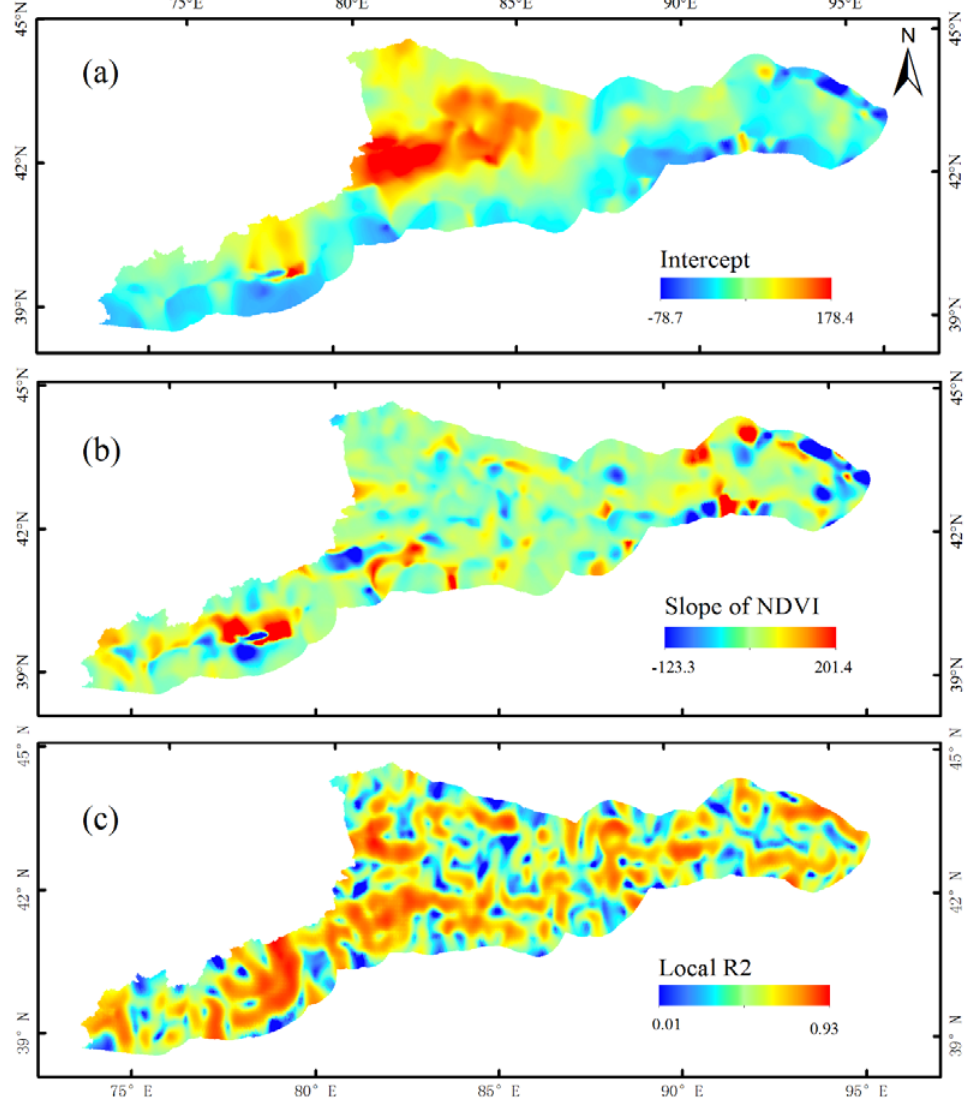
Figure 3. The spatial distributions of the ( a ) intercept, ( b ) slope of the NDVI and, ( c ) local R 2 in July 2016.